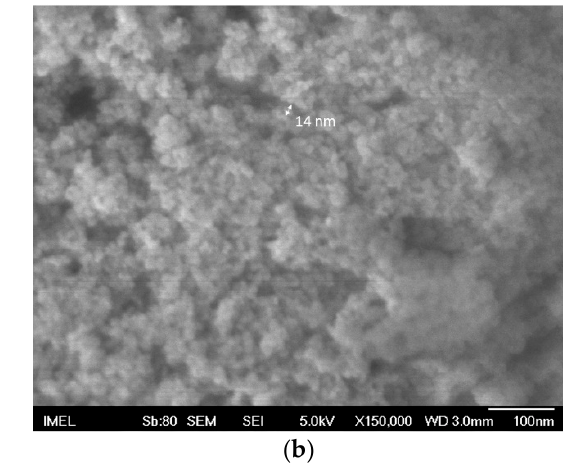
× 100,000 and ( b ) × 150,000 2 powder in ( a )